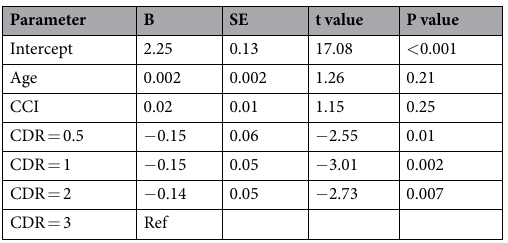
Table 3. Results of one-way analysis of covariance (ANCOVA) analyzing the differences in baseline plasma MCP-1 levels in AD patients. Dependent variable: plasma MCP-1 level (log transformation). MCP-1, Monocyte chemoattractant protein-1; CCI, Charlson Comorbidity Index; AD, Alzheimer’s disease; CDR, clinical dementia rating; SE, standard error.